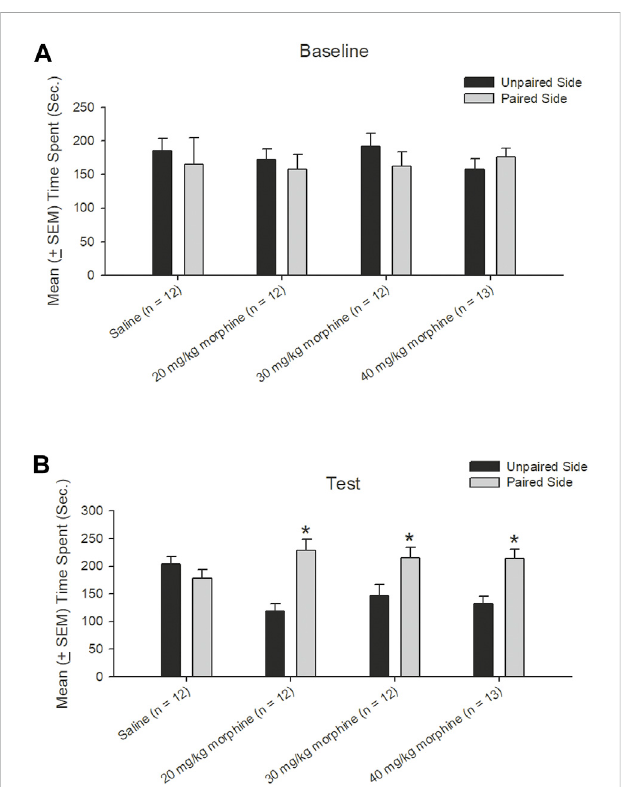
FIGURE 4 Morphine, the unconditioned stimulus agent, was paired with the contextualcompartmentoftheconditionedplacepreference(CPP) task to produce the CPP effect. Mean (±SEM) time spent between unpaired and paired sides in rats injected with saline ( n = 12) or with morphine in doses of 20 mg/kg ( n = 12), 30 mg/kg ( n = 12), and 40 mg/kg ( n = 13) in (A) baseline and (B) test phases, respectively. * p < 0.05 whencomparing theunpaired andpaired sides inthevariousdoses of